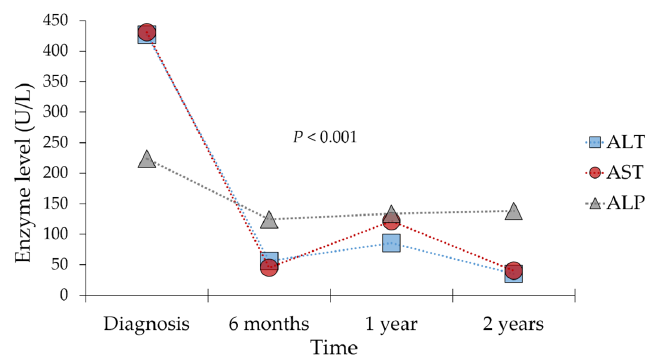
Figure 2. Response to treatment among patients at different time intervals as evidenced by liver function tests. ALT: Alanine aminotransferase in U/L; AST: Aspartate aminotransferase in U/L; ALP: Alkaline phosphatase in U/L. p values were calculated using the Kruskal–Wallis